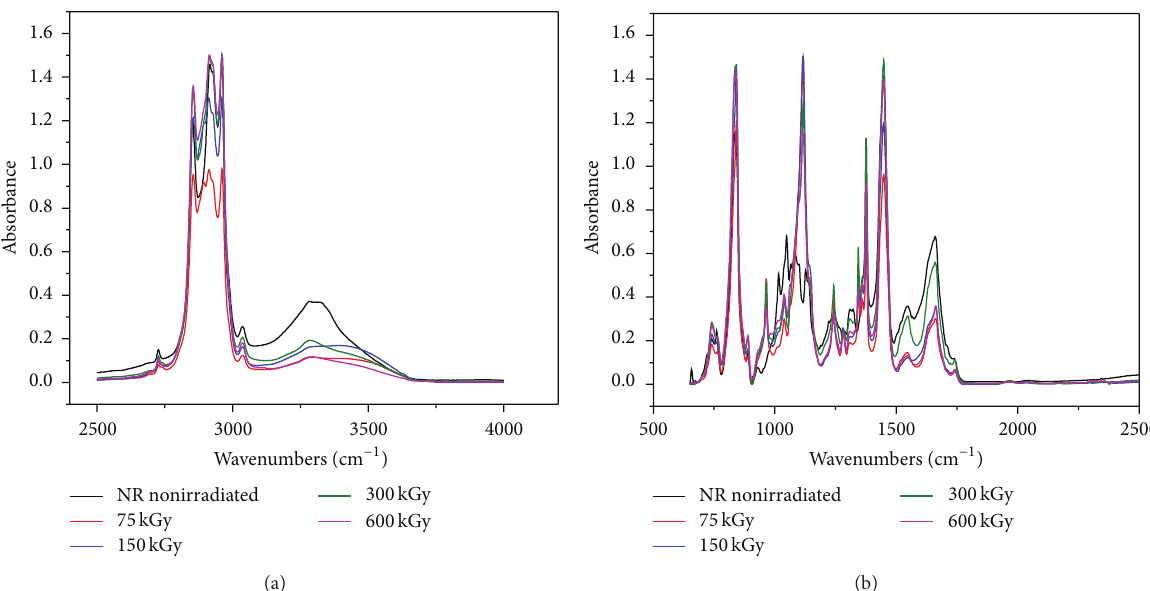
Figure 11: FTIR spectra for NR/hemp mixtures with 5phr hemp content: (a) between 2500–4000 and (b) between 500–2500.